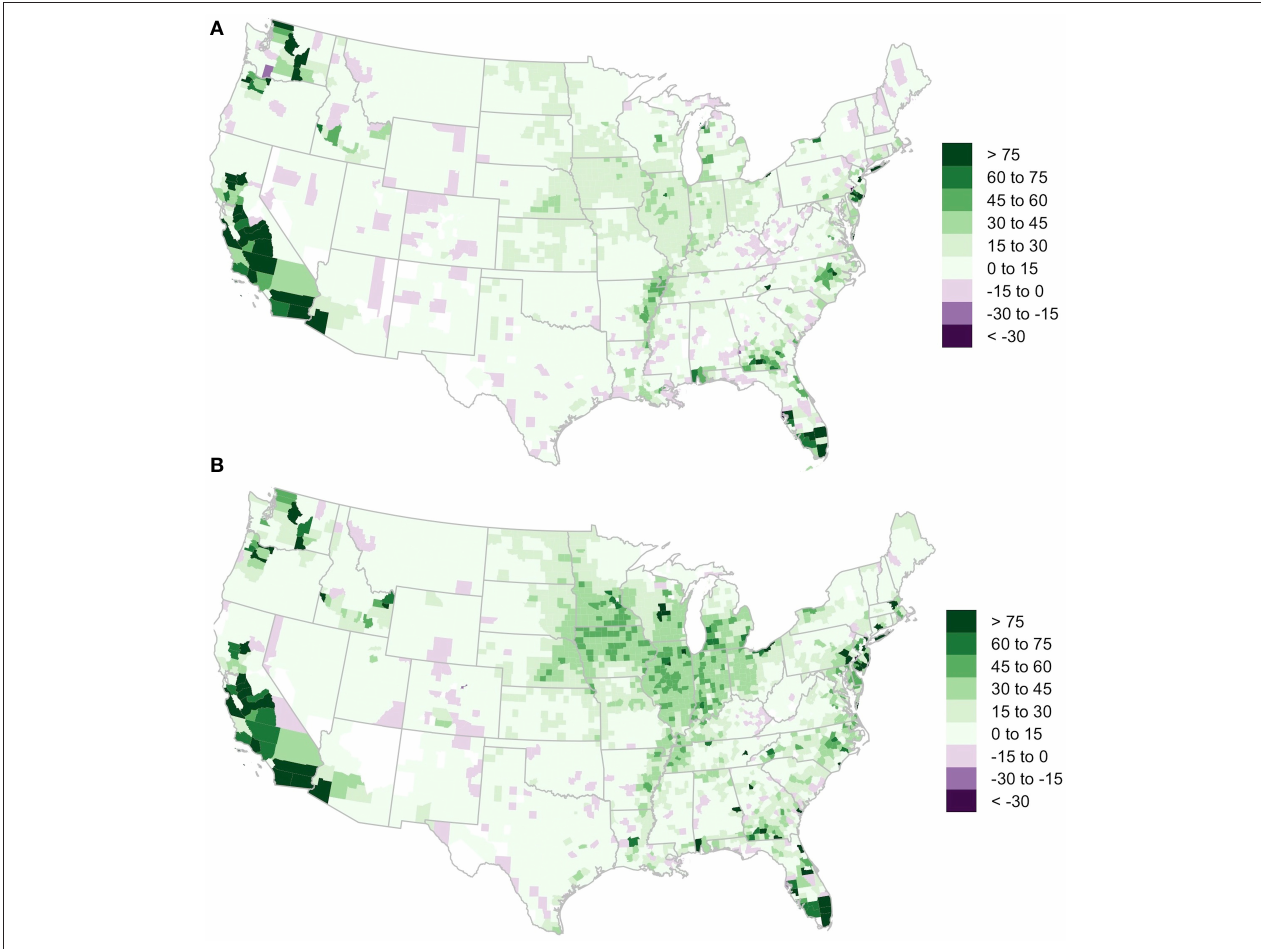
FIGURE 8 | Change (in USD) in inputs per operated acre by county between 1997 and 2017 by county. (A) Change (in USD) in chemical expense per operated acre. (B) Change (in USD) in fertilizer expense per operated acre. 1997 USD values are adjusted for inflation using average consumer price indices (CPI) from January-December 1997 (avg. CPI ∼ 160.52) and January-December 2017 (avg. CPI ∼ 245.12). Data: USDA NASS Census of